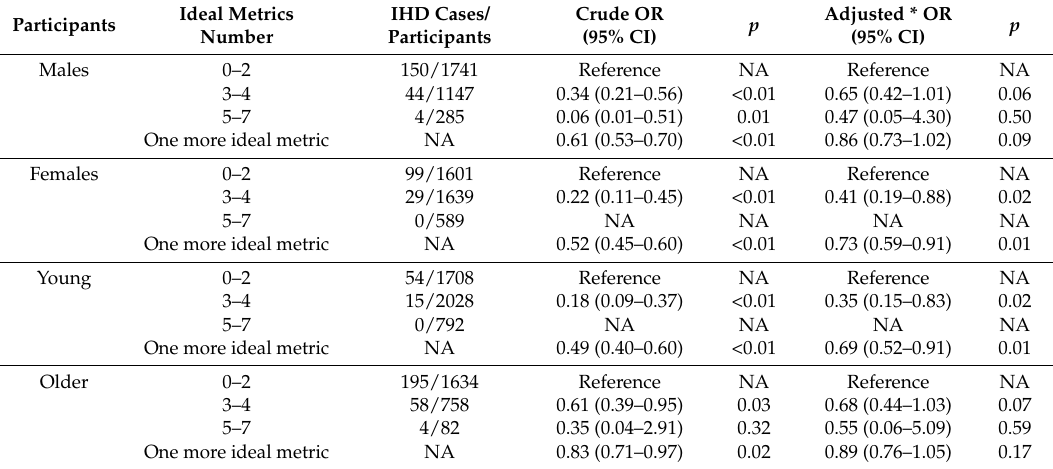
Table 4. ORs between number of ideal metrics and IHD prevalence, stratified by sex and